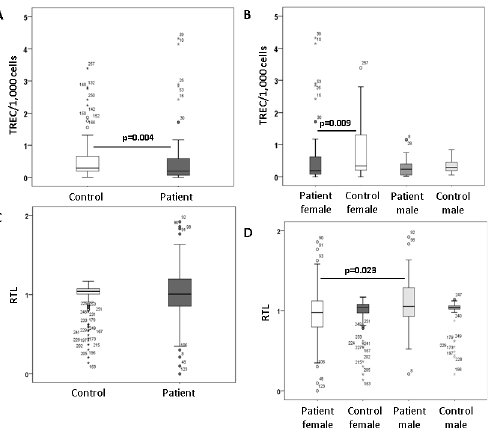
Fig 2. T cell receptor excision circles (TRECs). T cell receptor excision circles (TRECs) per 1,000 peripheral blood mononuclear cells (PBMCs) were significantly lower including all patients compared to controls (A) and in female patients with panic disorder compared to healthy female controls (B) (Mann- Whitney U test). Relative telomere lengths (RTLs) are shown in patients and compared to controls (C) and in female patients with panic disorder compared to healthy female controls (D) (Mann-Whitney U test). Circles (outliers) and asterisks (extreme values) represent individuals coded with numbers.